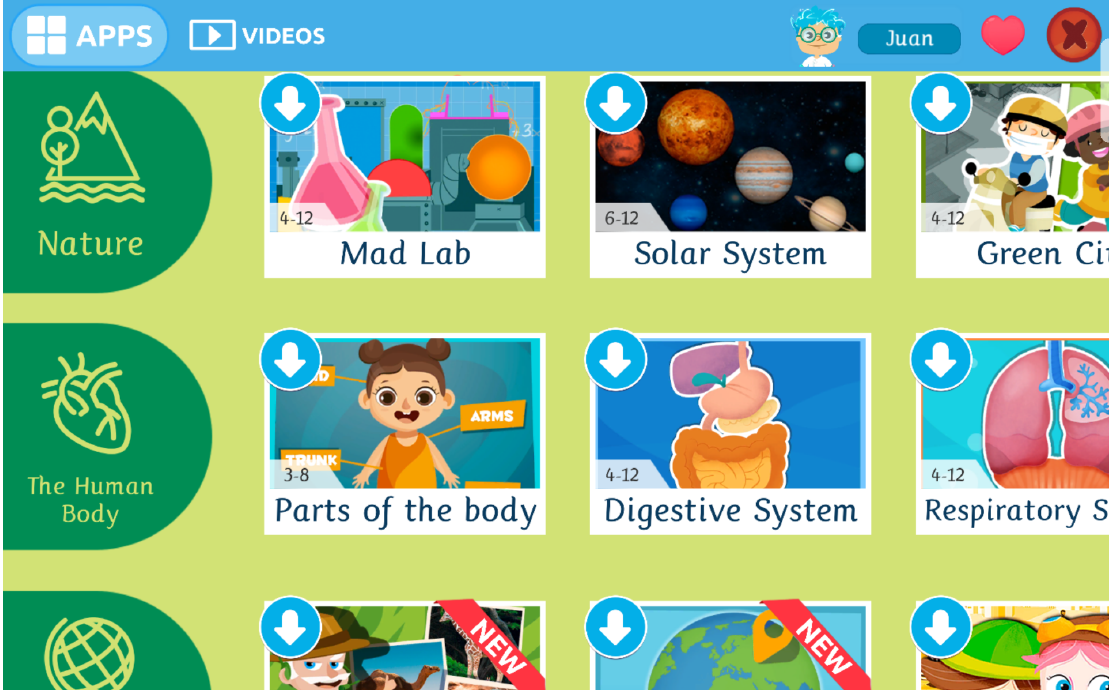
Figure 2. Screenshot of a world menu (in this case, the science world) in Smile and Learn, where apps belonging to the same world (or intelligence) are listed grouped by